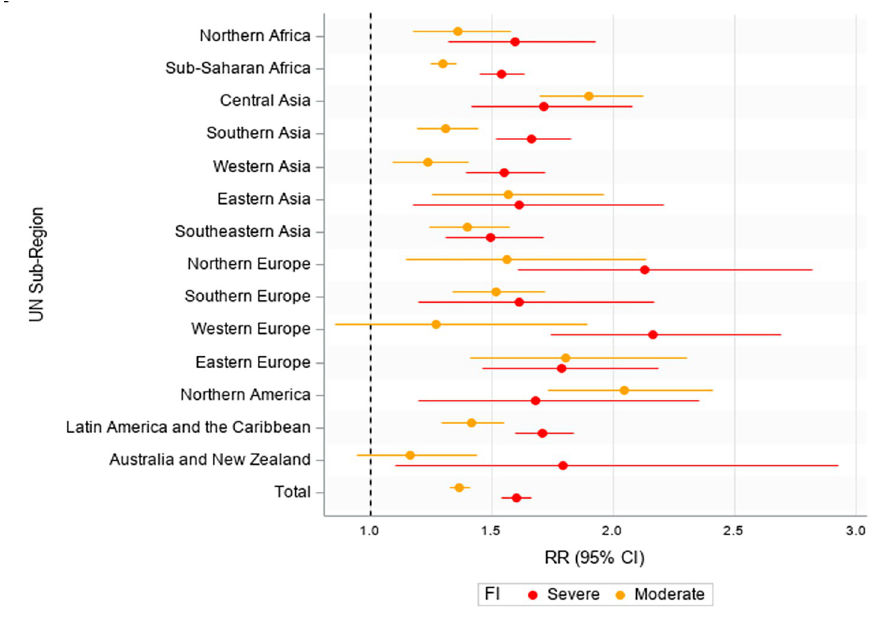
Fig 1. Forest plot showing the association between food insecurity (Food Insecurity Experiences Scale) and poor mental health (Daily Experience Index score) among n = 28,292 youth from the 2017 Gallup World Poll survey, by United Nations sub-region. Notes: There are 19 UN sub-regions (https://unstats.un.org/unsd/methodology/m49/ overview/). Estimates were adjusted for gender, urbanicity, marital status, education, employment, number of children < 15 in household, age, log annual household income, disaster severity (fixed effects), and country (random effect). Abbreviations: United Nations (UN), relative risk (RR), confidence interval (CI), food insecurity (FI).